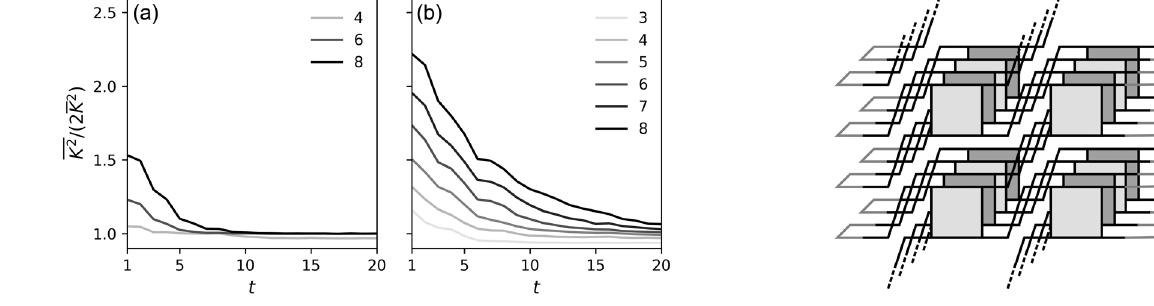
orbits.FIG. 22. Statistical fluctuations of K ð t Þ . Here, we show K 2 = ð 2 ¯ K 2 Þ , equal to 1 within RMT, for (a) periodic boundary conditions and (b) open boundary conditions. The system size L is shown on the